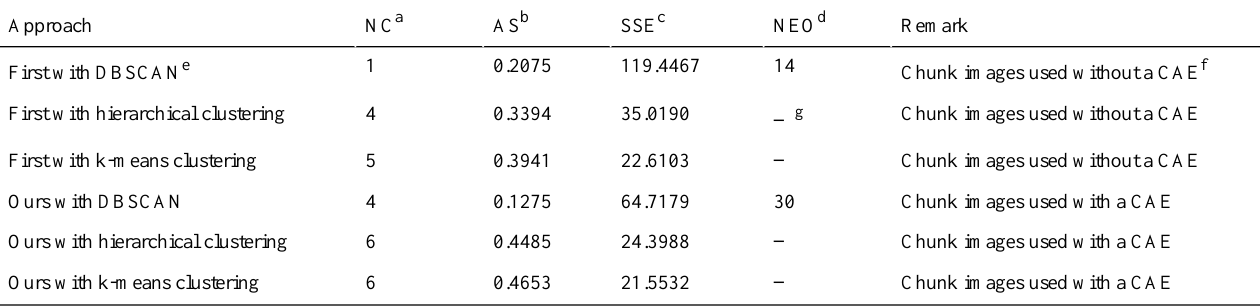
Table 1. Evaluation of user clustering results for two diachronic